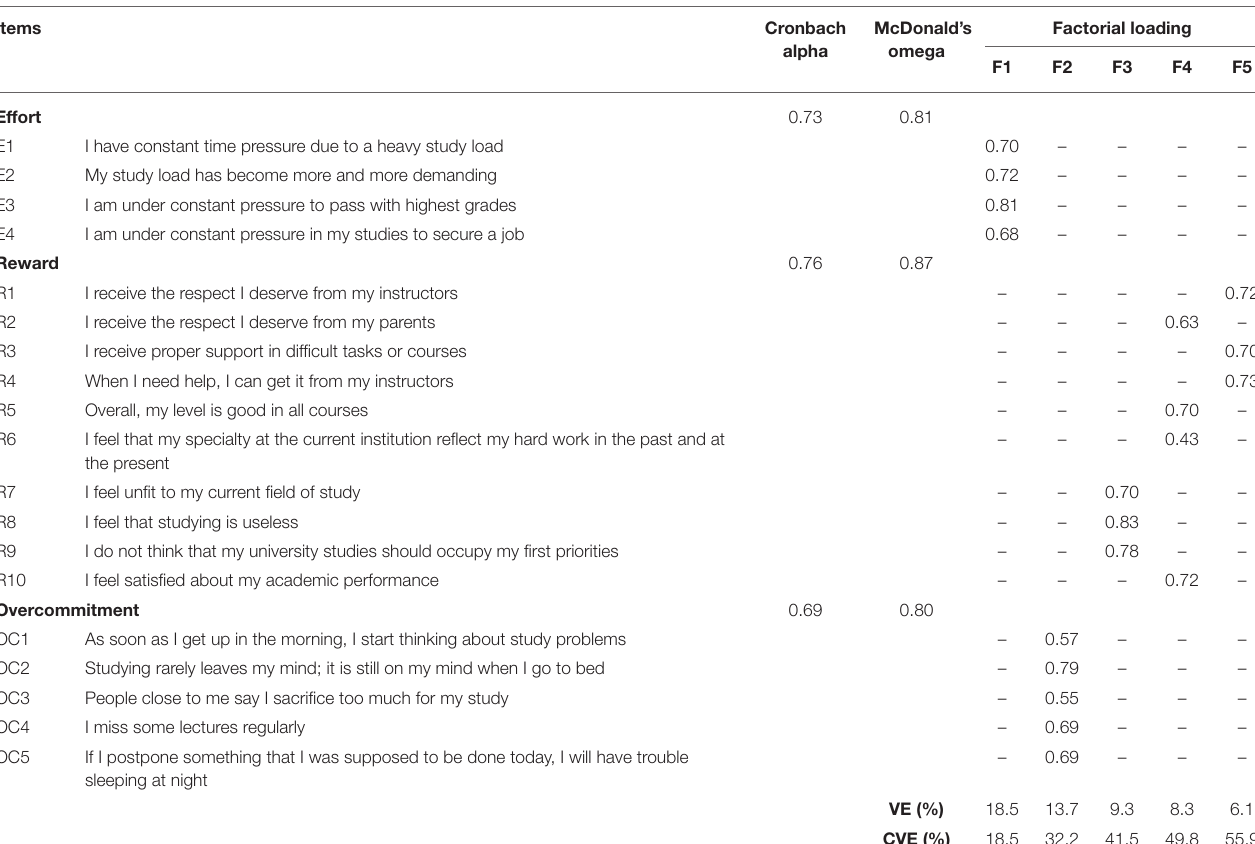
TABLE 5 | Reliability measures and factorial structure of the effort, reward and overcommitment scales. Items